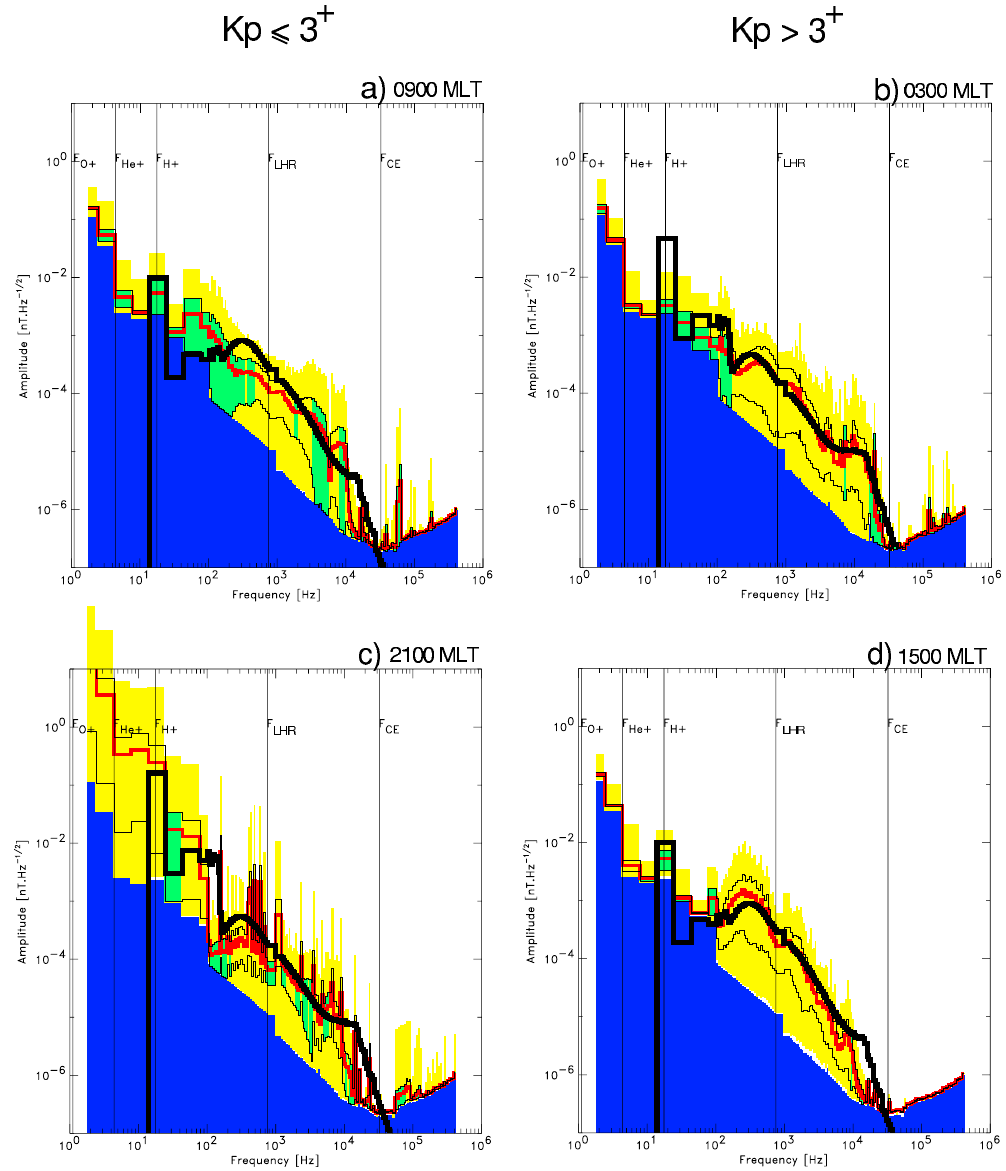
Fig. 7. Comparison between modelled (heavy black line) and observed (red lines) averaged amplitude spectra at L = 3 and (a) 09:00MLT, (b) 03:00MLT, (c) 21:00MLT and (d) 15:00MLT. The magnetic activity is weak on left panels and strong on right panels. The instrumental noise (blue bars) and the maximum amplitudes (yellow bars) have been superimposed on the